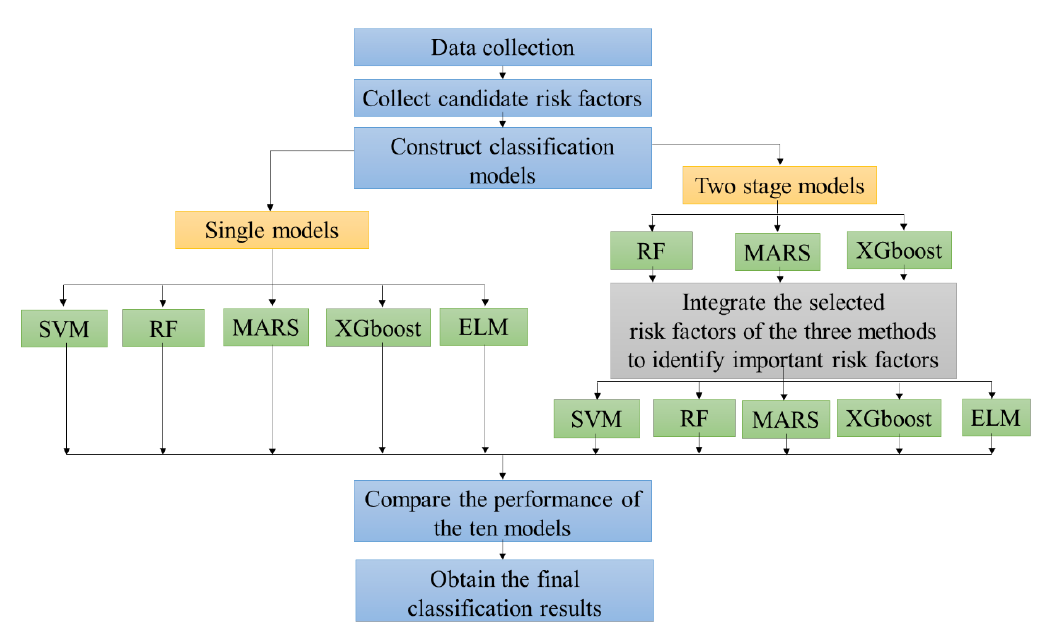
Figure 1. The flowchart of the proposed second primary cancer (SPC) prediction scheme in colorectal cancer patients.